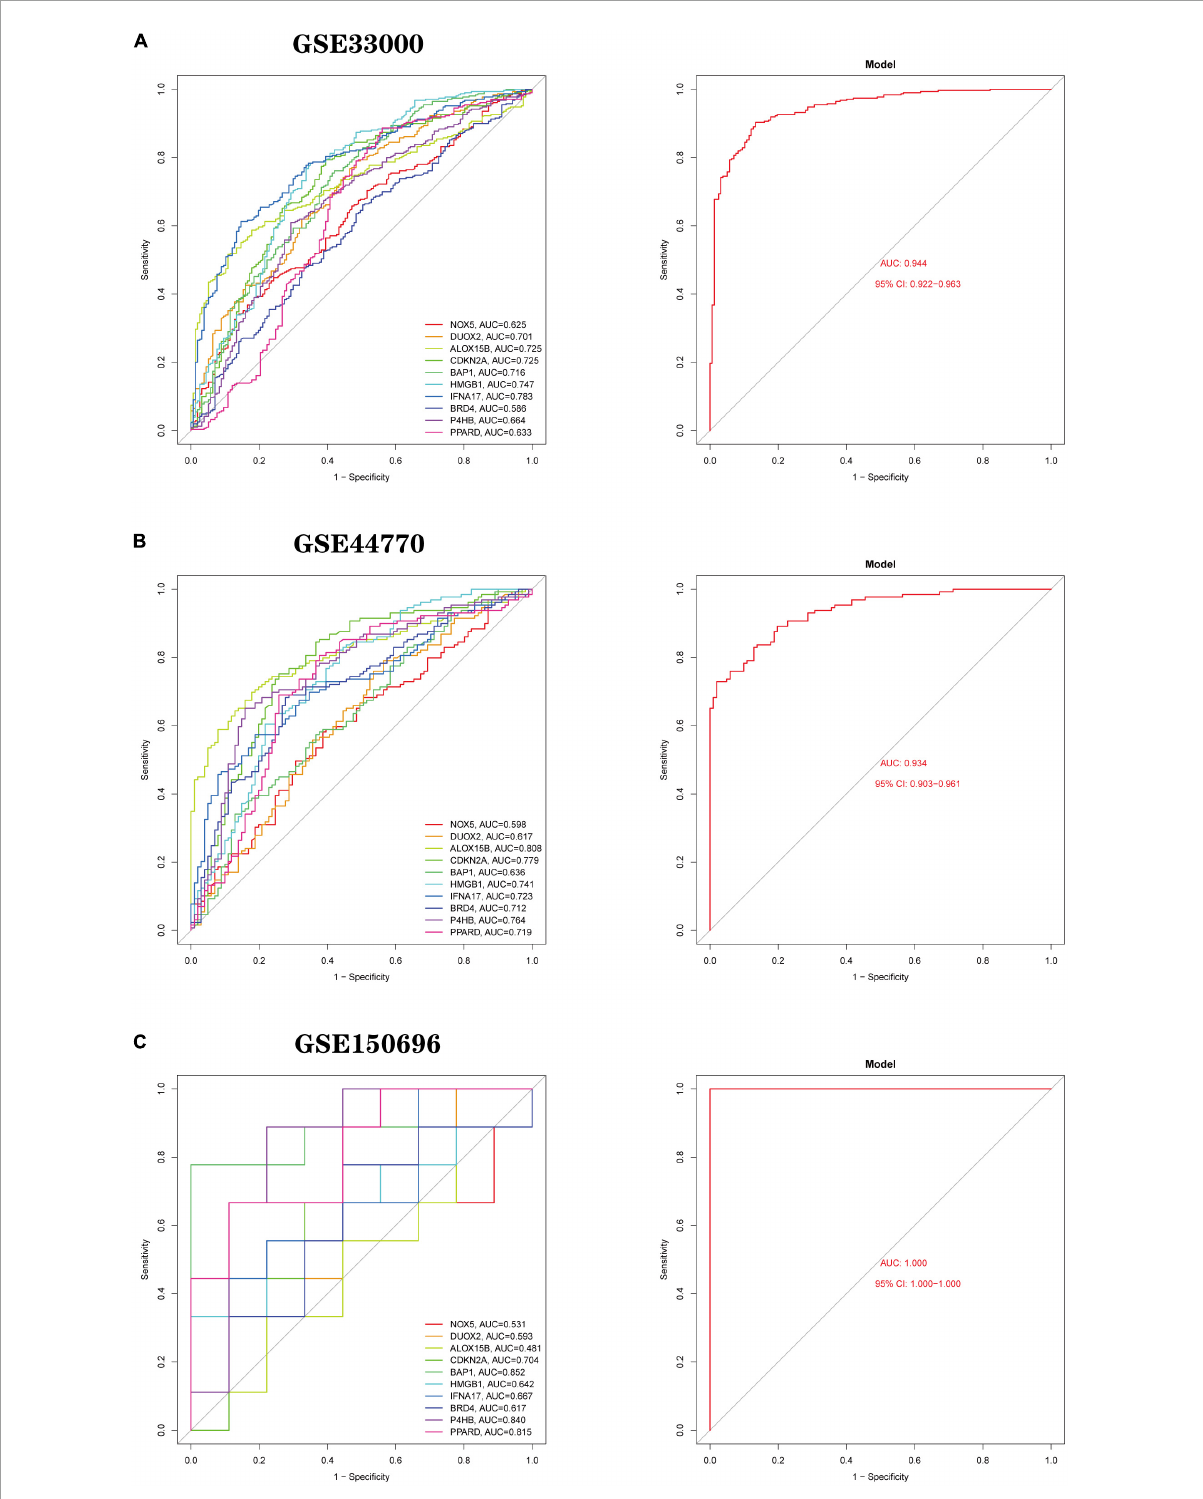
FIGURE13 Logistic regression model building and ROC curve validation. (A) ROC curves of the training set GSE33000 dataset, (left) ROC curves of Hub genes, and (right) ROC curves of the model. (B) The validation set GSE44770 dataset, (left) ROC curve of Hub gene, (right) ROC curve of the model. (C) The validation set GSE150696, (left) ROC curves of Hub gene, (right) ROC curves of the model. The different coloured lines represent different